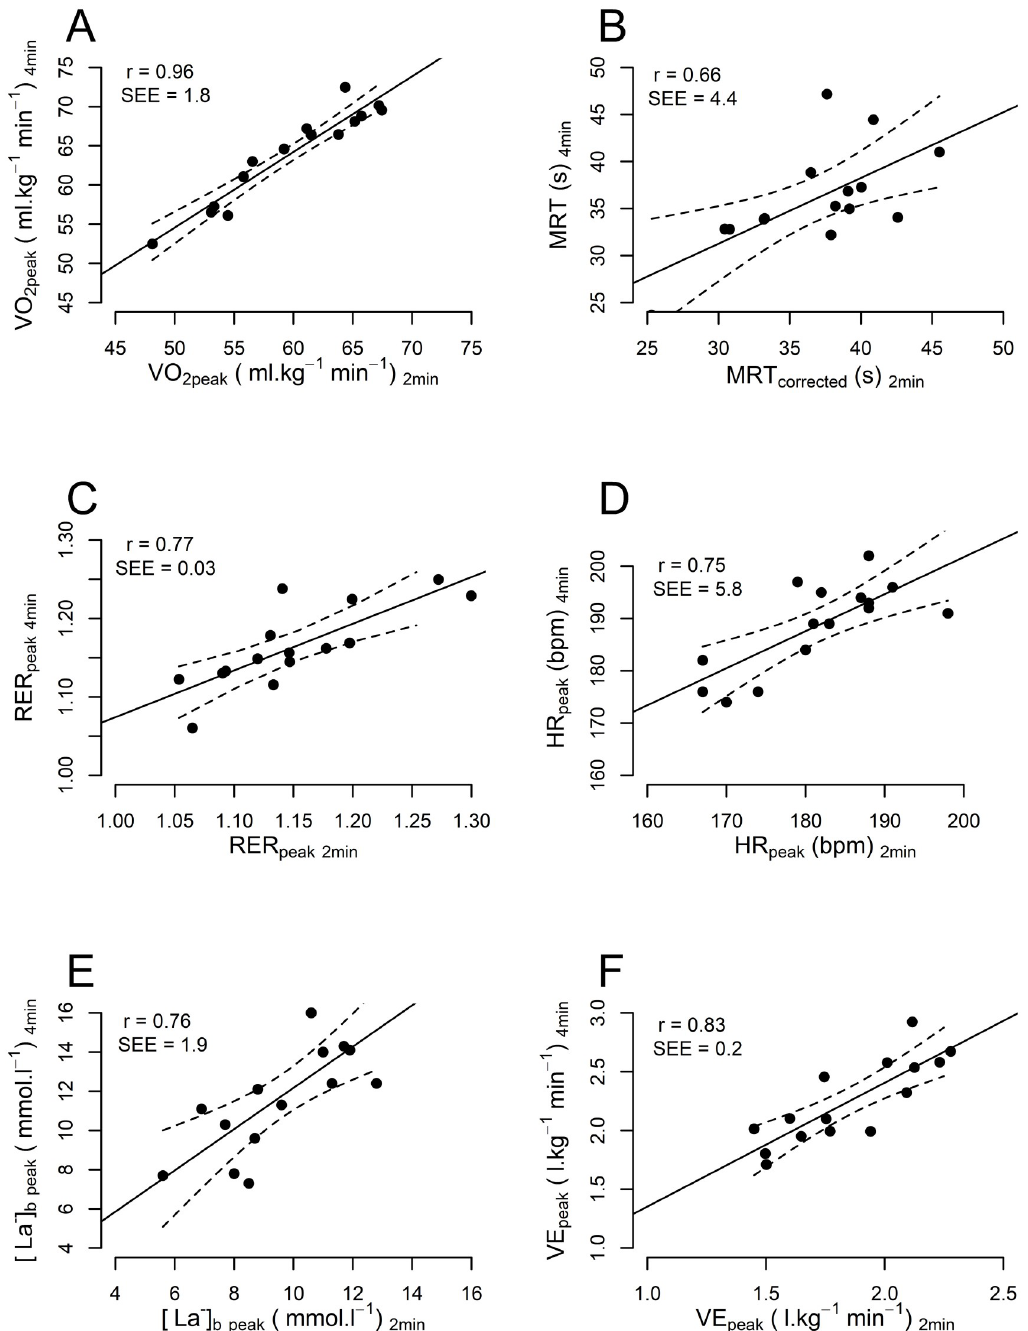
Fig 2. Relationships between physiological changes induced by 2- and 4-min CWR tests. Correlation and absolute standard error of the estimates (SEE) between the CWR tests are displayed on the top left corner of each graph. Dotted lines indicate the 95% CI. Moderate to very strong relationships were observed between physiological variables obtained during the 2- and 4-min CWR tests.